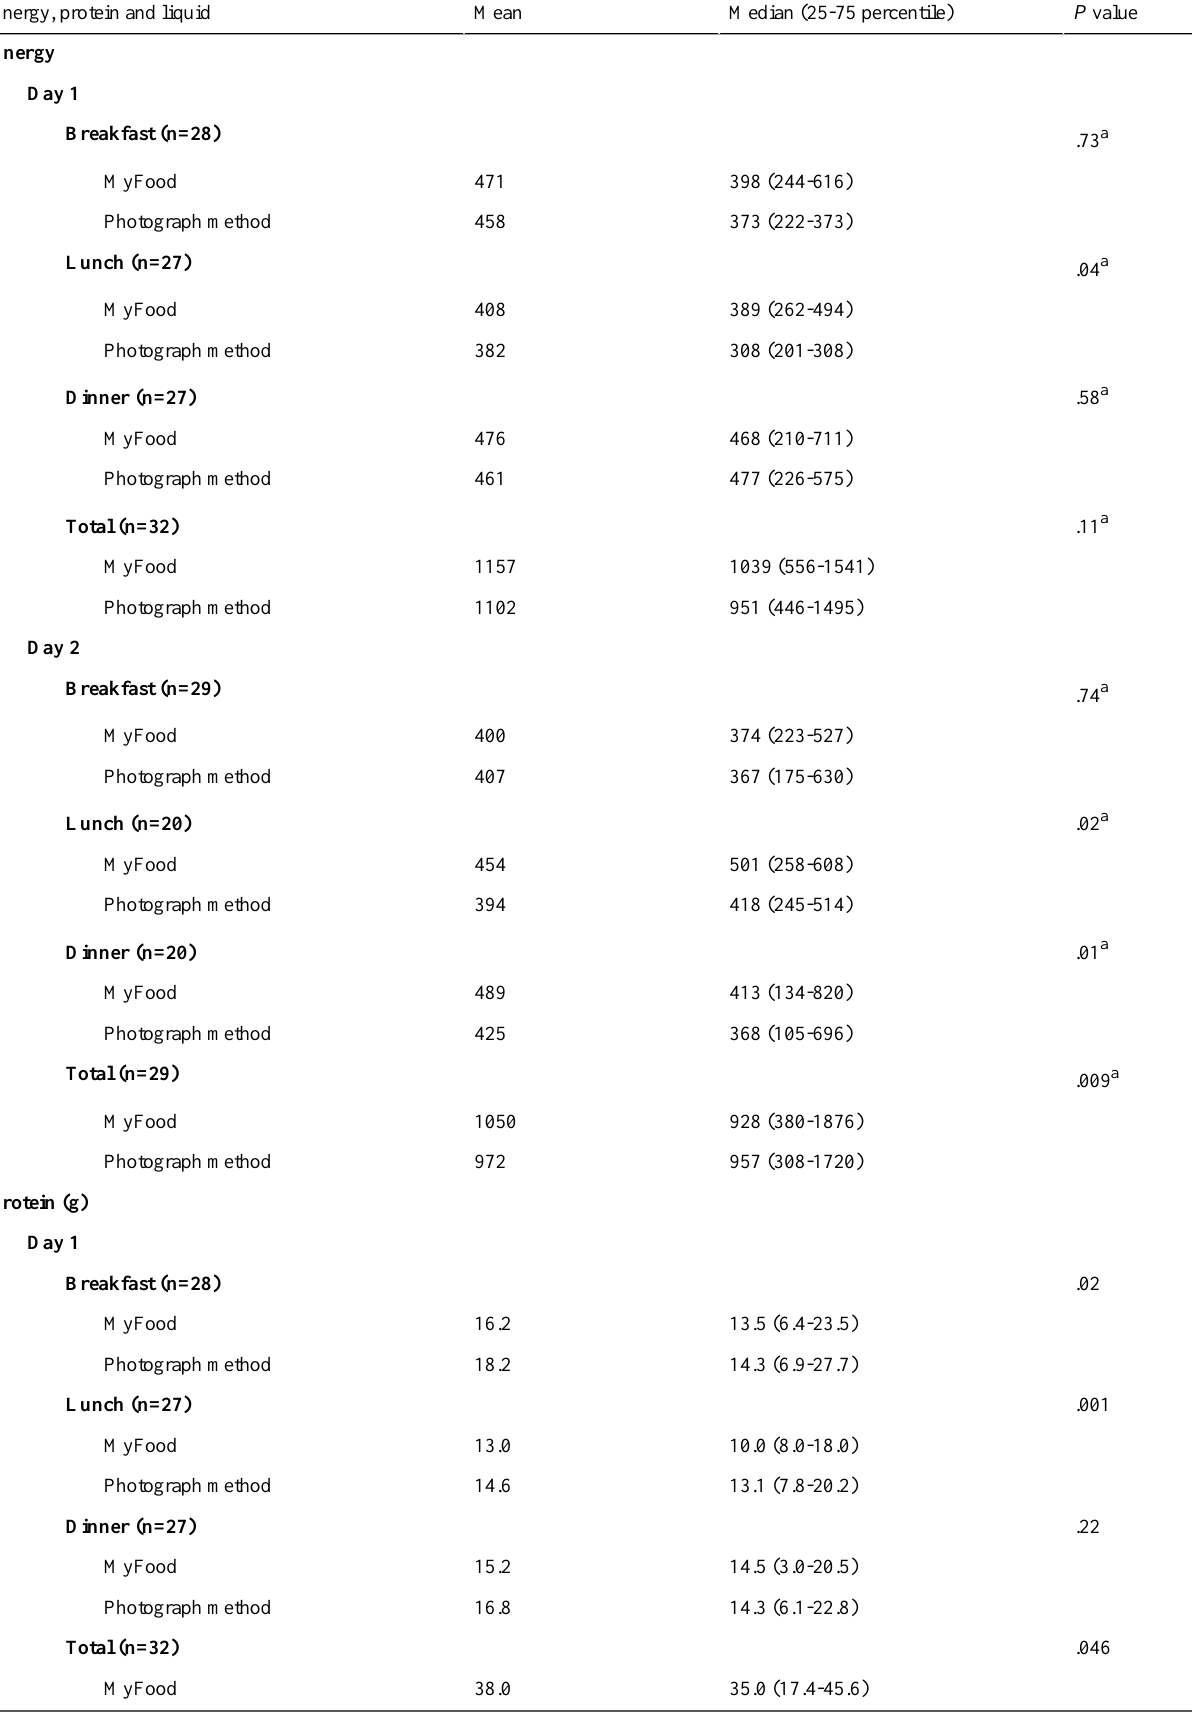
Table 2. Energy, protein, and liquid consumption recorded in MyFood compared to the photograph method. The data are presented as a total of the breakfast, lunch, and dinner meals, and separately for each